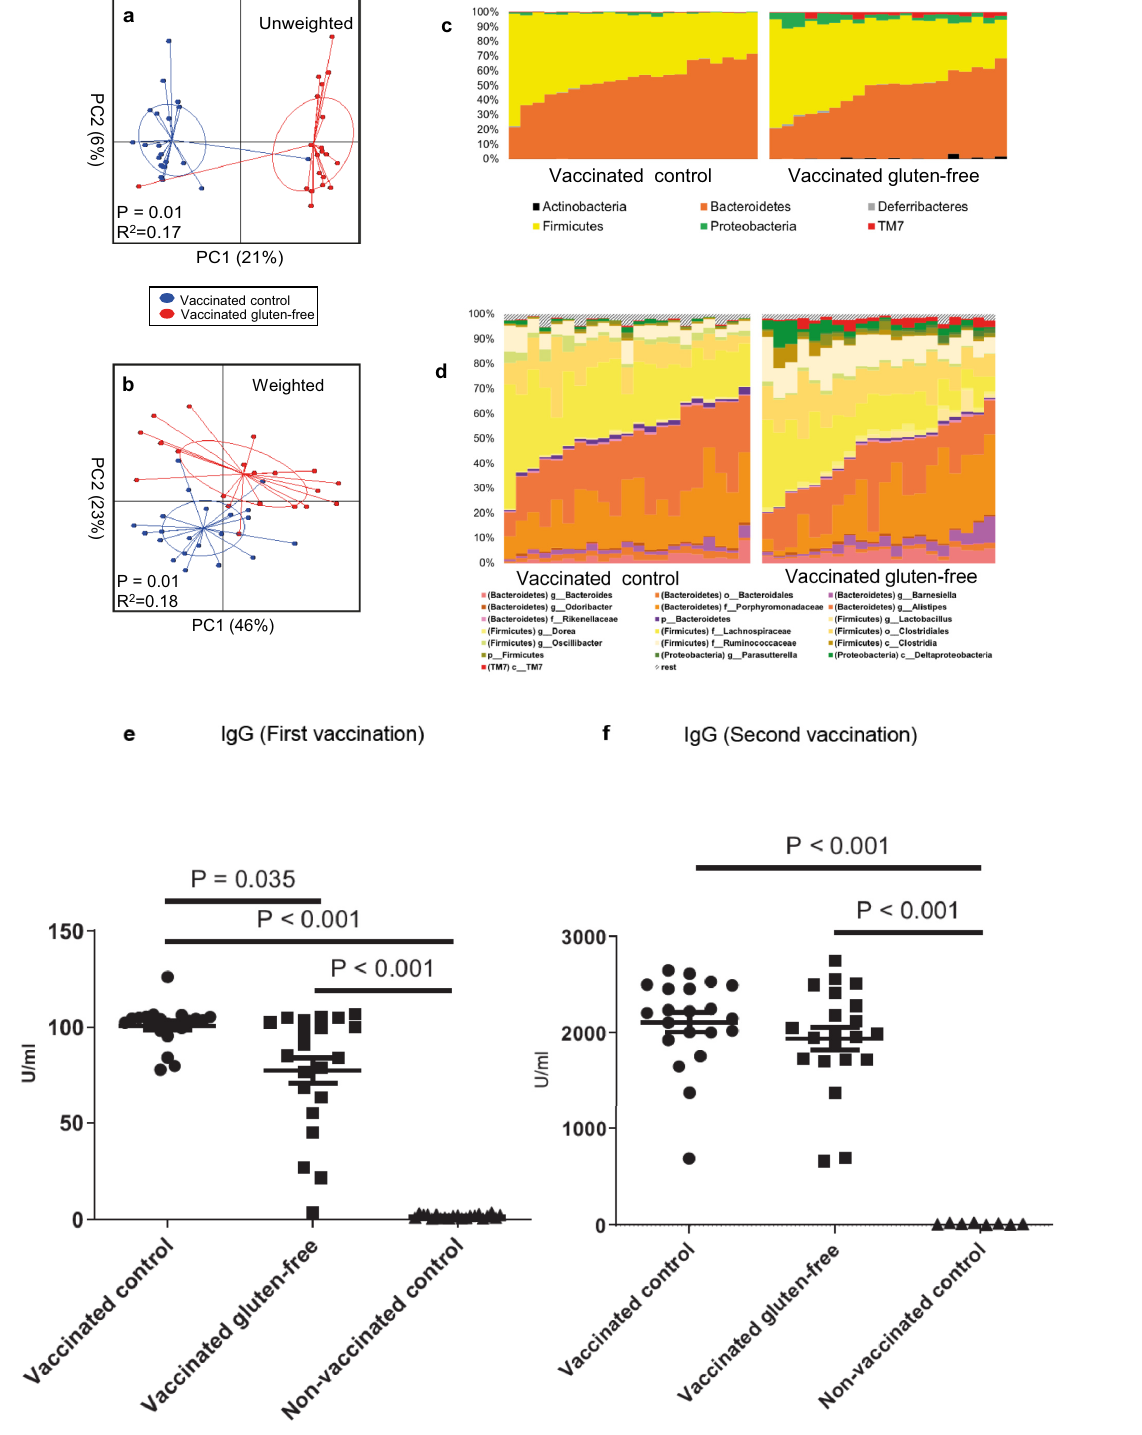
Fig 2. The impact of a gluten-free diet on gut microbiota and anti-tetanus IgG after tetanus vaccination. BALB/cBomTac mice were vaccinated or not and fed a standard Altromin wheat based diet (‘gluten’), or they were vaccinated and fed a modified Altromin diet, in which wheat protein was replaced with casein (‘gluten-free’). Unweighted (a) and weighted (b) PCoA plots with Permutational multivariate analysis of variance (PERMANOVA) results, relative abundance bar plots on phylum (c) and OTU (d) level after microbiota characterization on feces sampled three and a half week after second vaccination, and anti-tetanus IgG (median) two and a half week after first (e) and three and a half week after second (f) tetanus vaccination. https://doi.org/10.1371/journal.pone.0266719.g002 PLOS ONE | https://doi.org/10.1371/journal.pone.0266719 April 13,